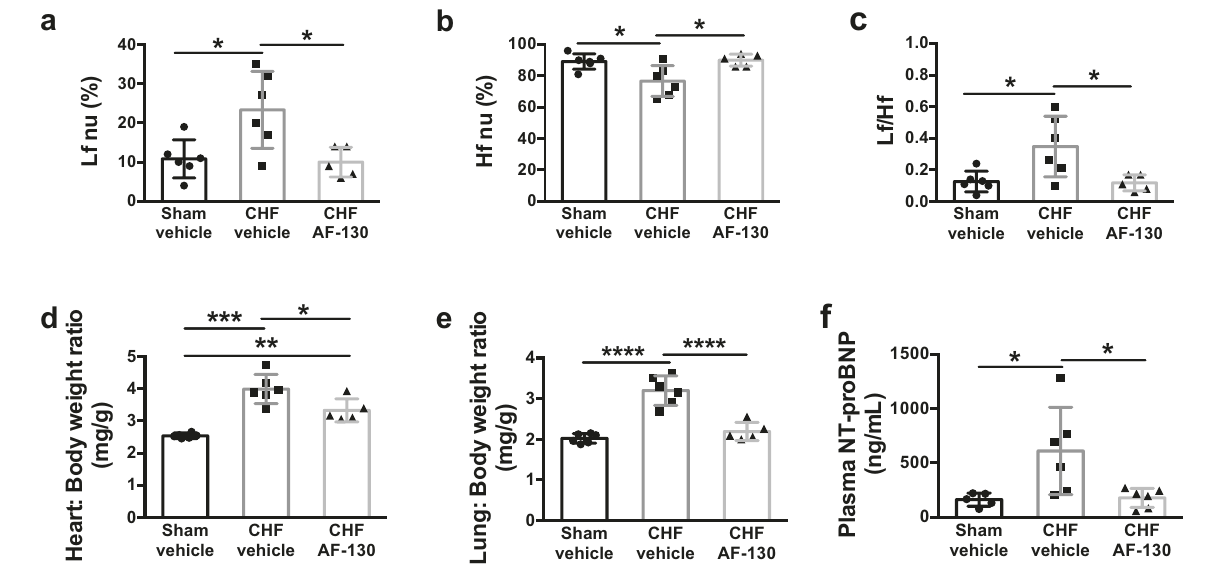
Fig. 5 | Chronic treatment with AF-130 improved heart rate variability (HRV) and reduced heart failure (HF) severity in chronic HF (CHF) rats. HRV was examined in the frequency domain (Hz) by spectral analysis. AF-130 treatment improved the cardiac sympathovagal modulation in CHF rats. a Lf: Low-frequency power; b Hf: high-frequency power and c Lf/Hf; nu: normalized units. P2X3- receptor antagonismattenuated the increase in d heartweights/bodyweightratio, and prevented the rise in e lung /bodyweight ratio and f plasma N-TerminalPro-B-